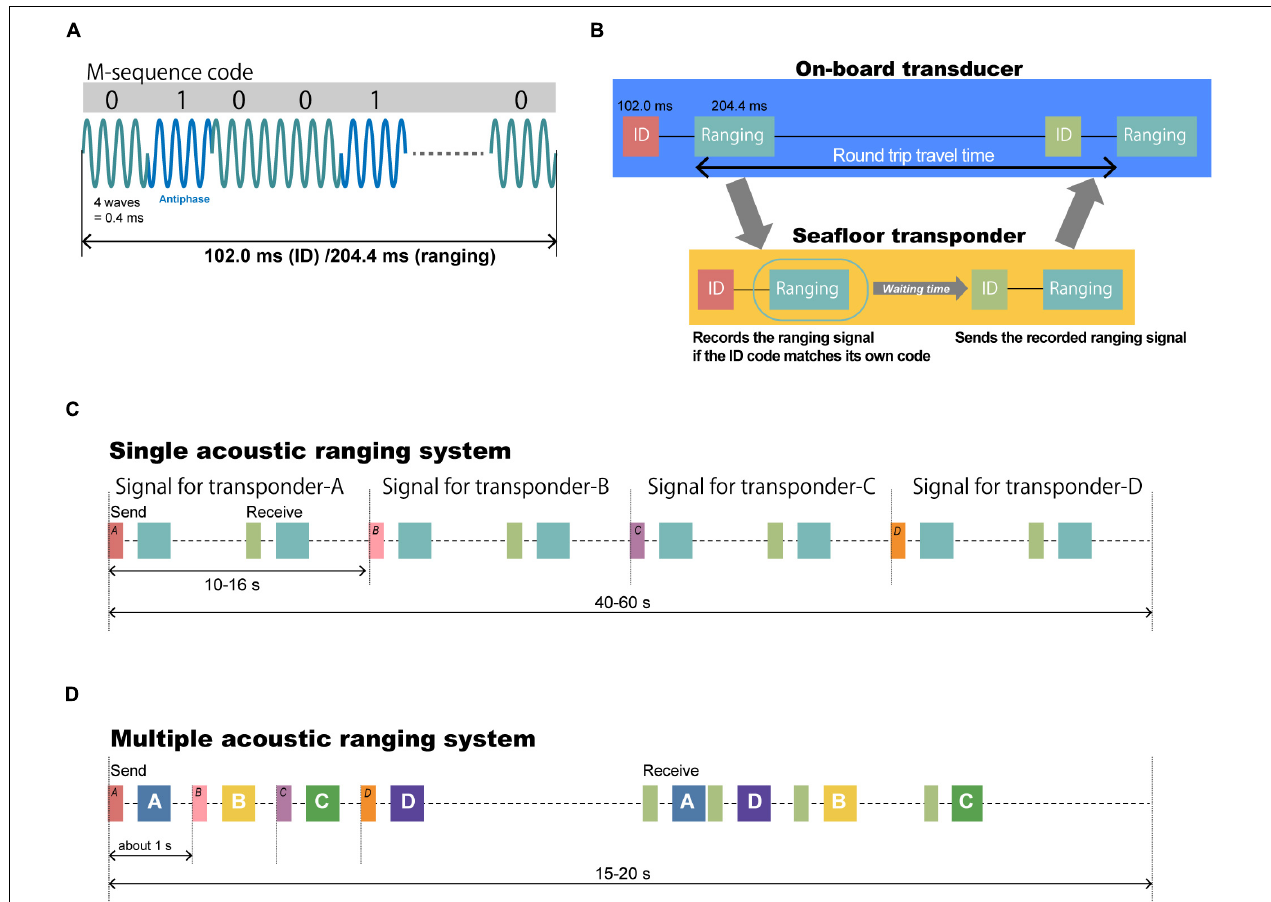
FIGURE 2 | Outline of the acoustic ranging system. (A) Acoustic waves coded by four-wave M-sequence signals. (B) Flowchart of transmission and reception of acoustic signals. Comparison of transmission and reception sequences in (C) the single acoustic ranging system (pole system and hull-mounted system) and (D) the multiple acoustic ranging system (new hull-mounted system). ID, identification